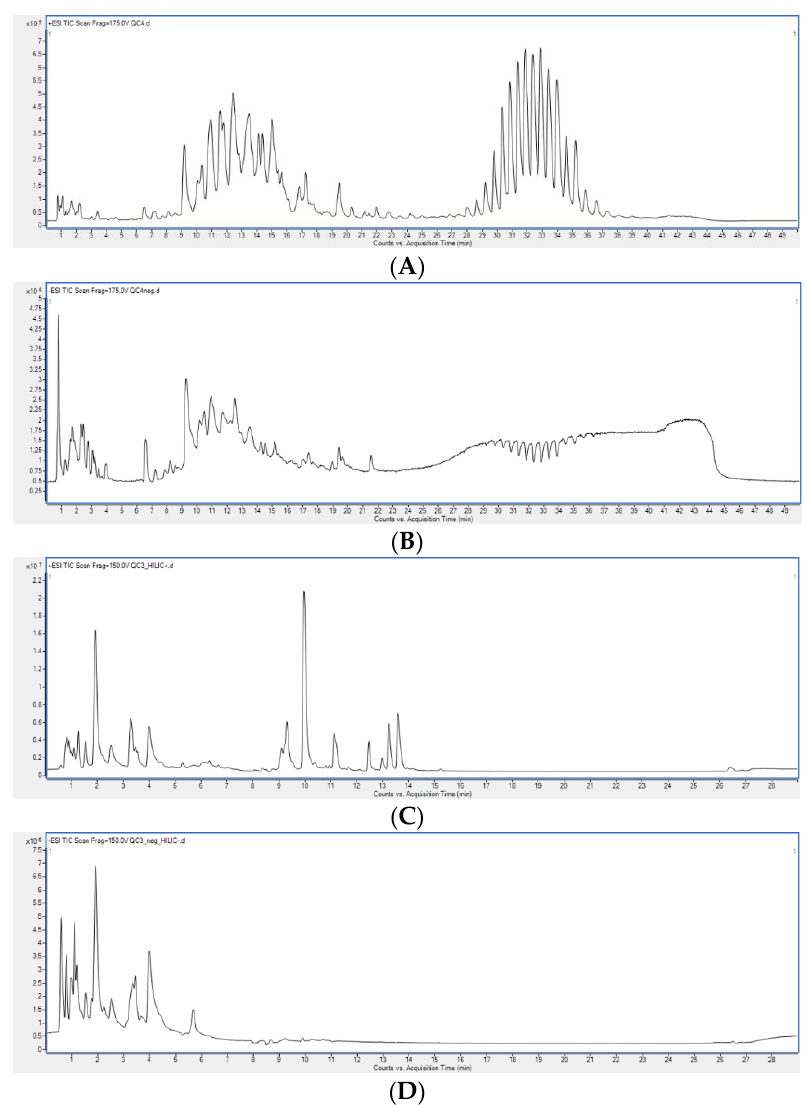
Figure 2. Chromatograms of exemplary samples obtained during ( A ) RP-LC-MS (+), ( B ) RP-LC-MS(-), ( C ) HILIC-LC-MS(+), ( D ) HILIC-LC-MS(-) analyses.